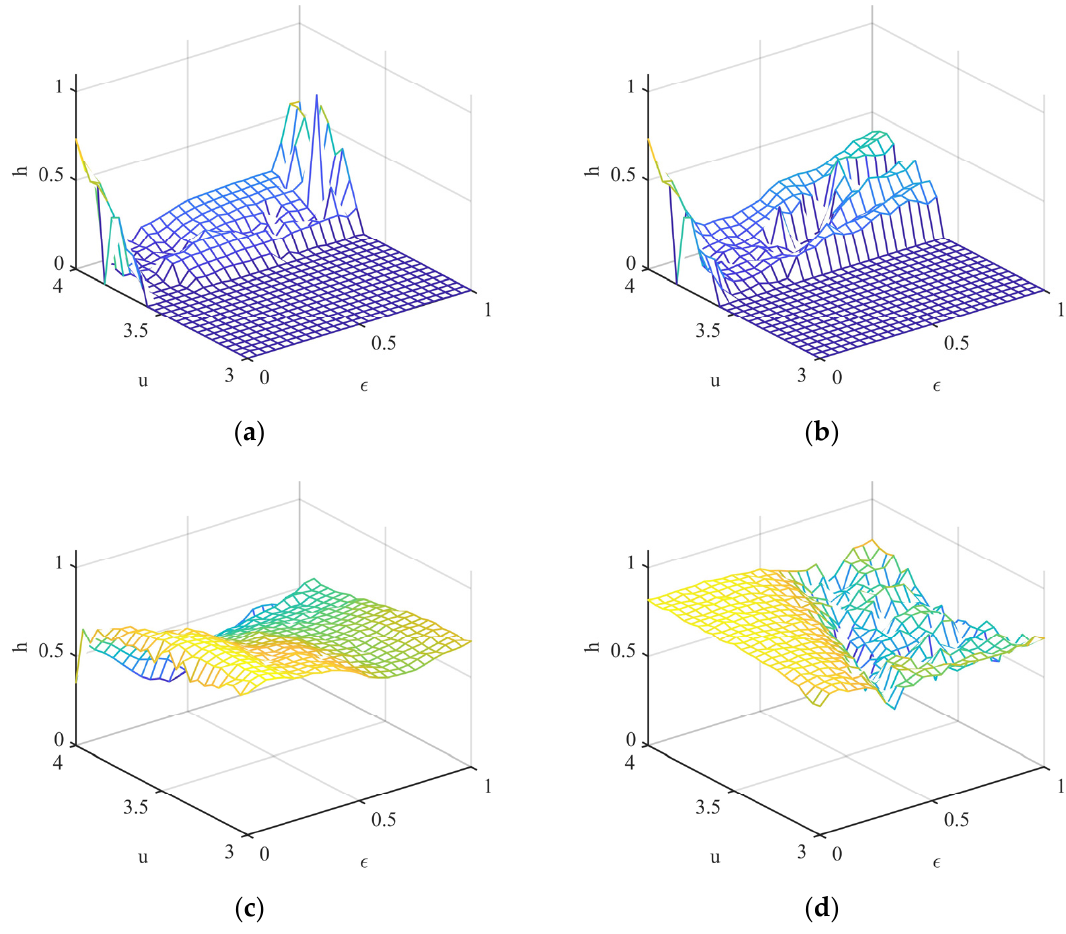
Figure 4. KEDs of ( a ) 2D-CML, ( b ) 2D-NLCML, ( c ) 2D-MCPML and ( d ) 2D-DPRCML.